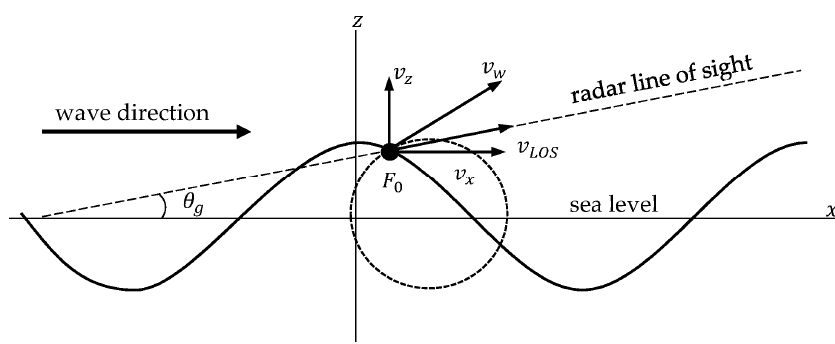
Figure 2. Velocities of the dominant facet F 0 orbiting with a long surface wave. The radar is not shown here, but it transmits from right to left along the LOS and it is close to the sea surface. v x , v z and v LOS are three projections of v w to x -axis, z -axis, and LOS , respectively. Compared with v x , the phase of v LOS is delayed by θ g Equation (7) is similar to Equation (5) except for the constant values 𝑥 (cid:2868) and 𝑧 (cid:2868) , and the phase difference 𝜃 (cid:3034) between 𝑣 (cid:3051) and 𝑣 (cid:3013)(cid:3016)(cid:3020) . Furthermore, supposing that 𝜃 (cid:3034) is a constant, 𝑣 (cid:3013)(cid:3016)(cid:3020) is also a periodic cosine function with period of 𝑇 . If a continuous radar signal with a stable frequency 𝑓 (cid:3021) is transmitted to the dominant facet 𝐹 (cid:2868) along the radar LOS , the Doppler effect modifies the continuous wave, and the Doppler shift frequency 𝑓 (cid:3031) is calculated with: